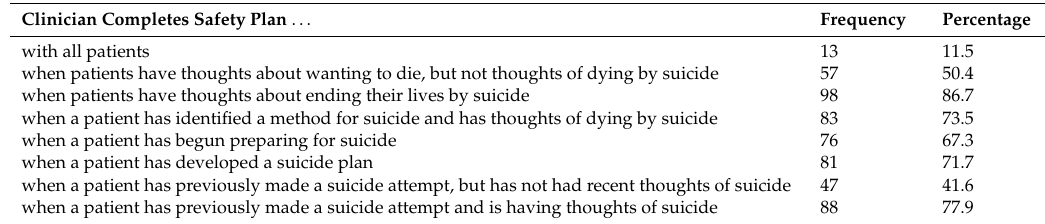
Table 2. Frequency of clinician safety plan